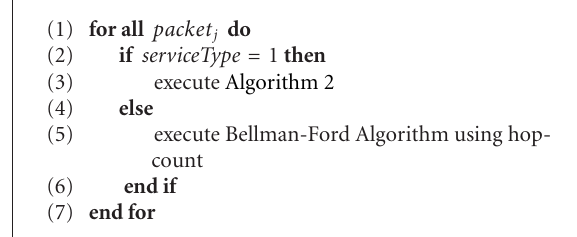
Algorithm 3: Service di ff erentiation at